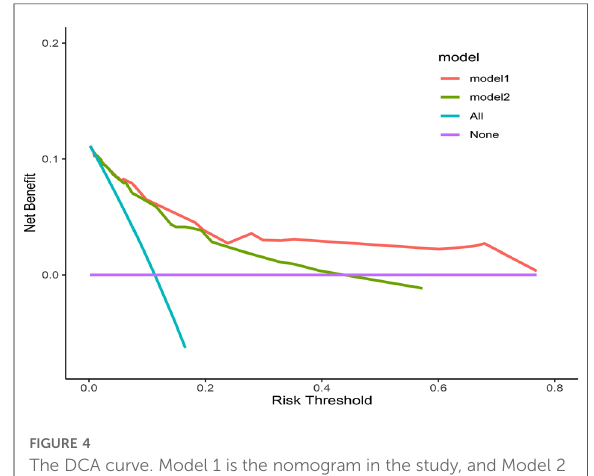
FIGURE 4 The DCA curve. Model 1 is the nomogram in the study, and Model 2 is the control model, which is composed of variables such as tumor size, histological type, ulcer and invasion depth.